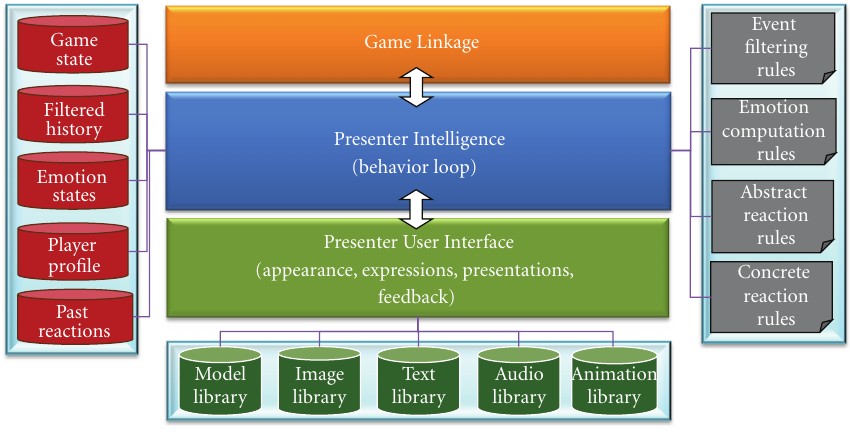
Figure 2: The high-level architecture of the